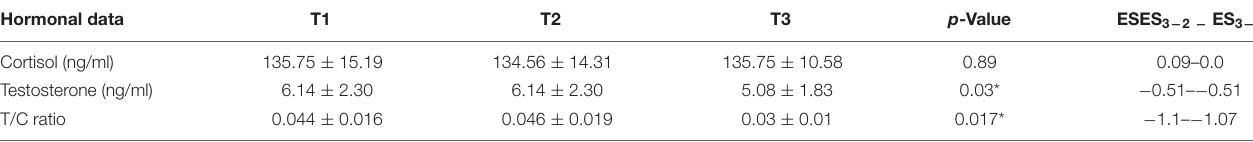
TABLE 6 | Changes of hormonal parameters during the 12 weeks training period. Hormonal data